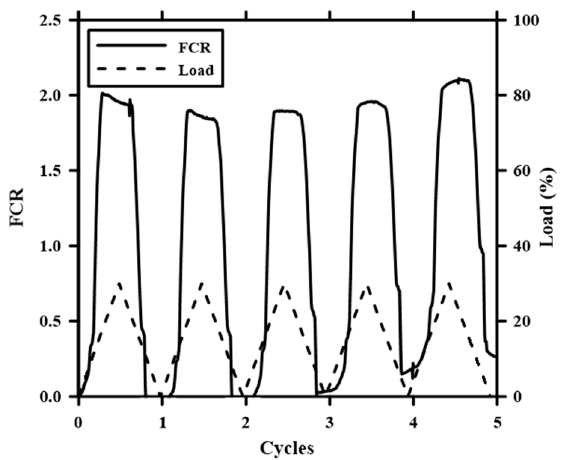
Figure 12. Flexural strength after application of repair composites.